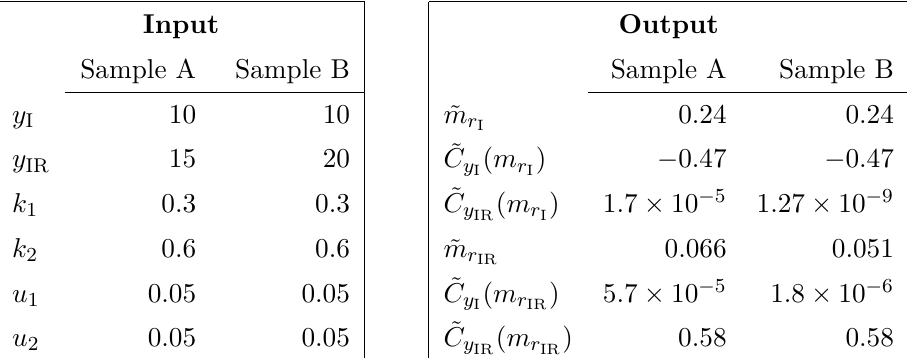
Table 1 . The radion couplings to matter fields living on the intermediate and IR branes. Two example cases are considered as sample A and sample B. The left table summarizes input parameters in unit of M 5 . In the right table, ˜ m r and ˜ m r are, respectively, the normalized heavier and I IR